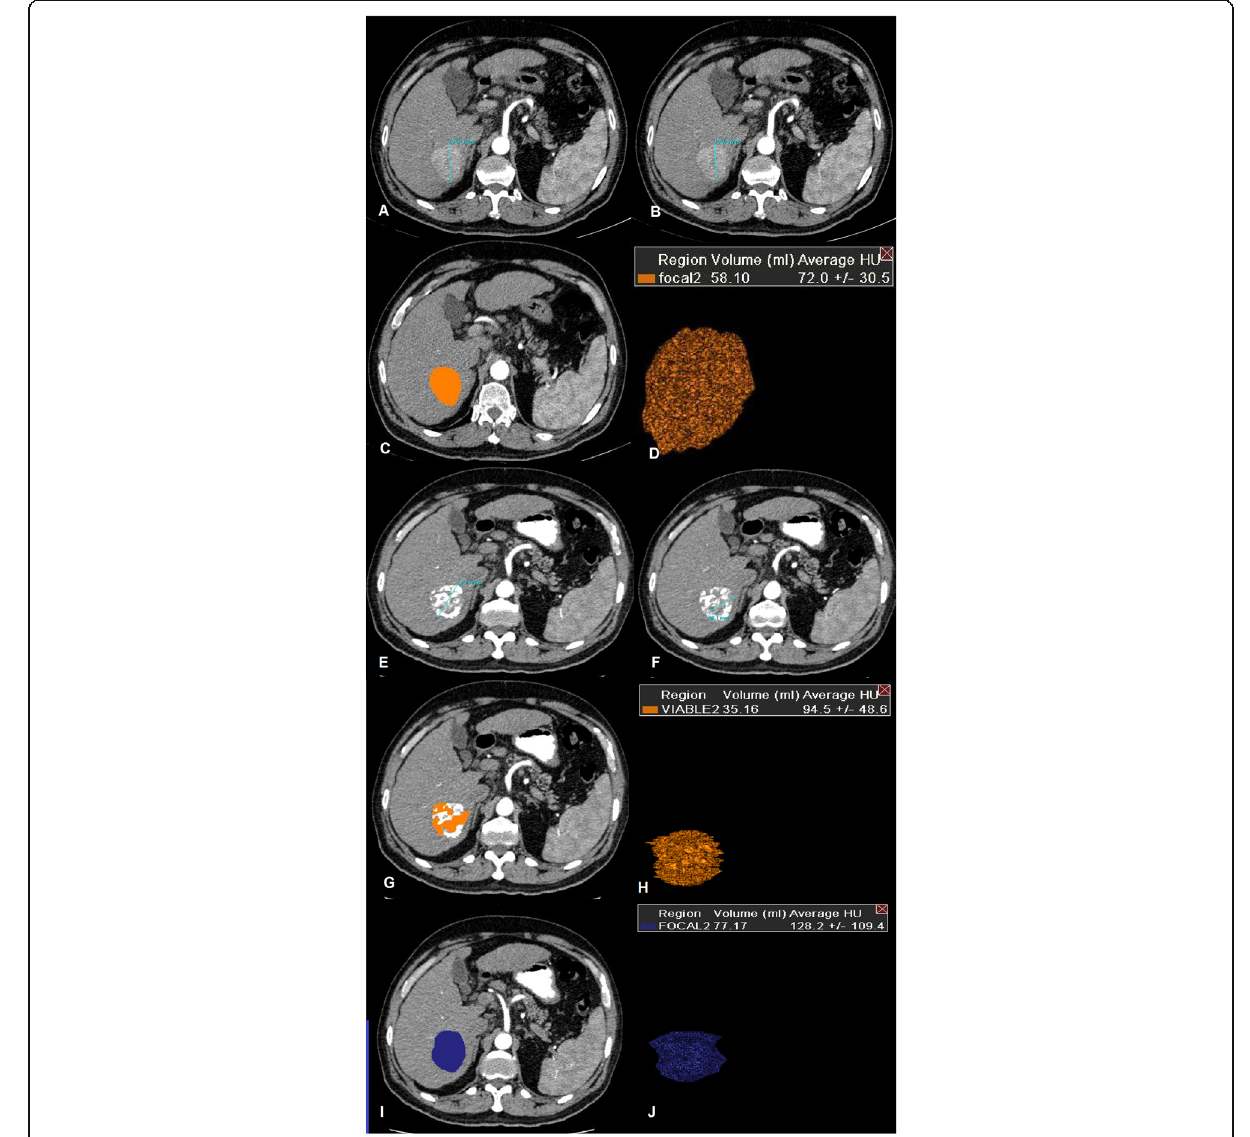
Fig. 1 A 66-year-old male with hepatitis C cirrhosis complicated by development of right lobe HCC. Child Pugh Score: A. BCLB: B. A Pre-TACE axial arterial phase image showing measurement of the lesion according to RECIST, B pre-TACE axial arterial phase image showing measurement of the lesion according to mRECIST and C pre-TACE axial arterial phase image showing measurement of the lesion according to vRECIST. D vRECIST 3D image showing the lesion ’ s volume, E post-TACE images showing lesion ’ s measurement according to RECIST, F measurement according to mRECIST by measuring the diameter of the enhancing component only, G volumetric assessment of the viable component only, H 3D image showing the volume of the viable component, I vRECIST of the whole lesion post TACE, and J 3D image of the whole lesion ’ s volume. According to mRECIST, the lesion shows stable disease (non-responder) (< 30% decrease in the diameter of viable component), while according to vRECIST, the lesion shows partial response (responder) (> 65% decrease in the diameter of viable enhancing component). This could be explained by the heterogeneity of the lesion which makes it difficult to measure a single diameter of the enhancing component which is